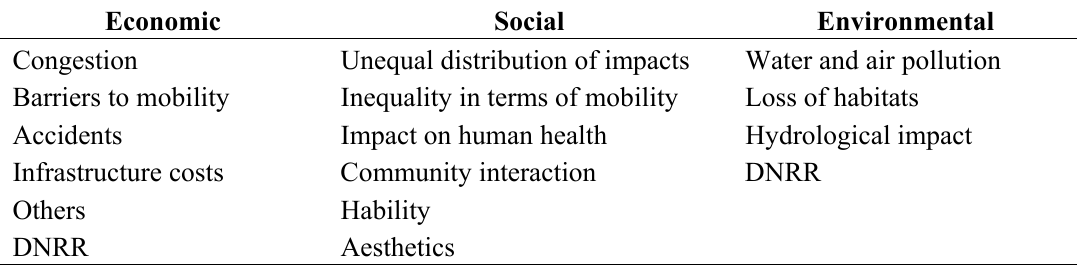
Table 3. Impacts of individual motorized transportation on society.